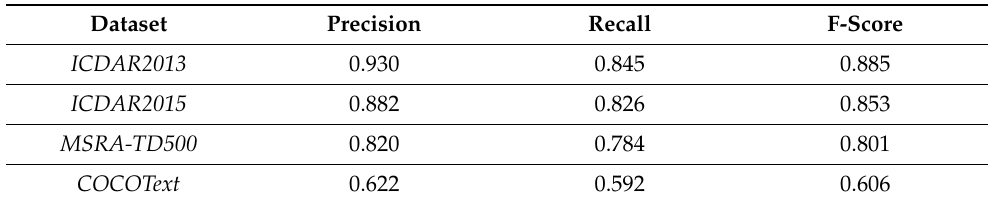
Table 2. MobileTDNet baseline detection